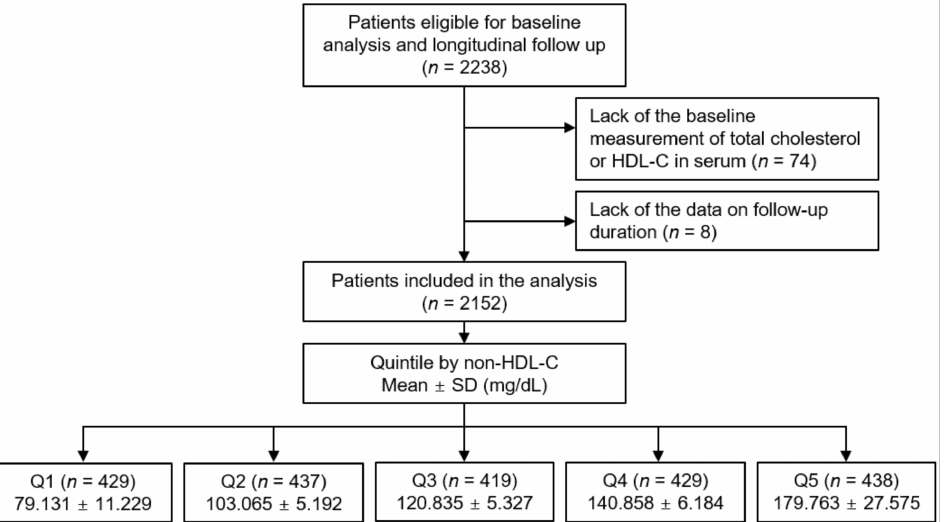
Figure 1. Schematic diagram of study design. Abbreviations: Non-HDL-C, non-high-density lipopro- tein cholesterol; HDL-C, high-density lipoprotein cholesterol; SD, standard deviation; Q1, 1st quintile; Q2, 2nd quintile, Q3, 3rd quintile; Q4, 4th quintile; Q5, 5th